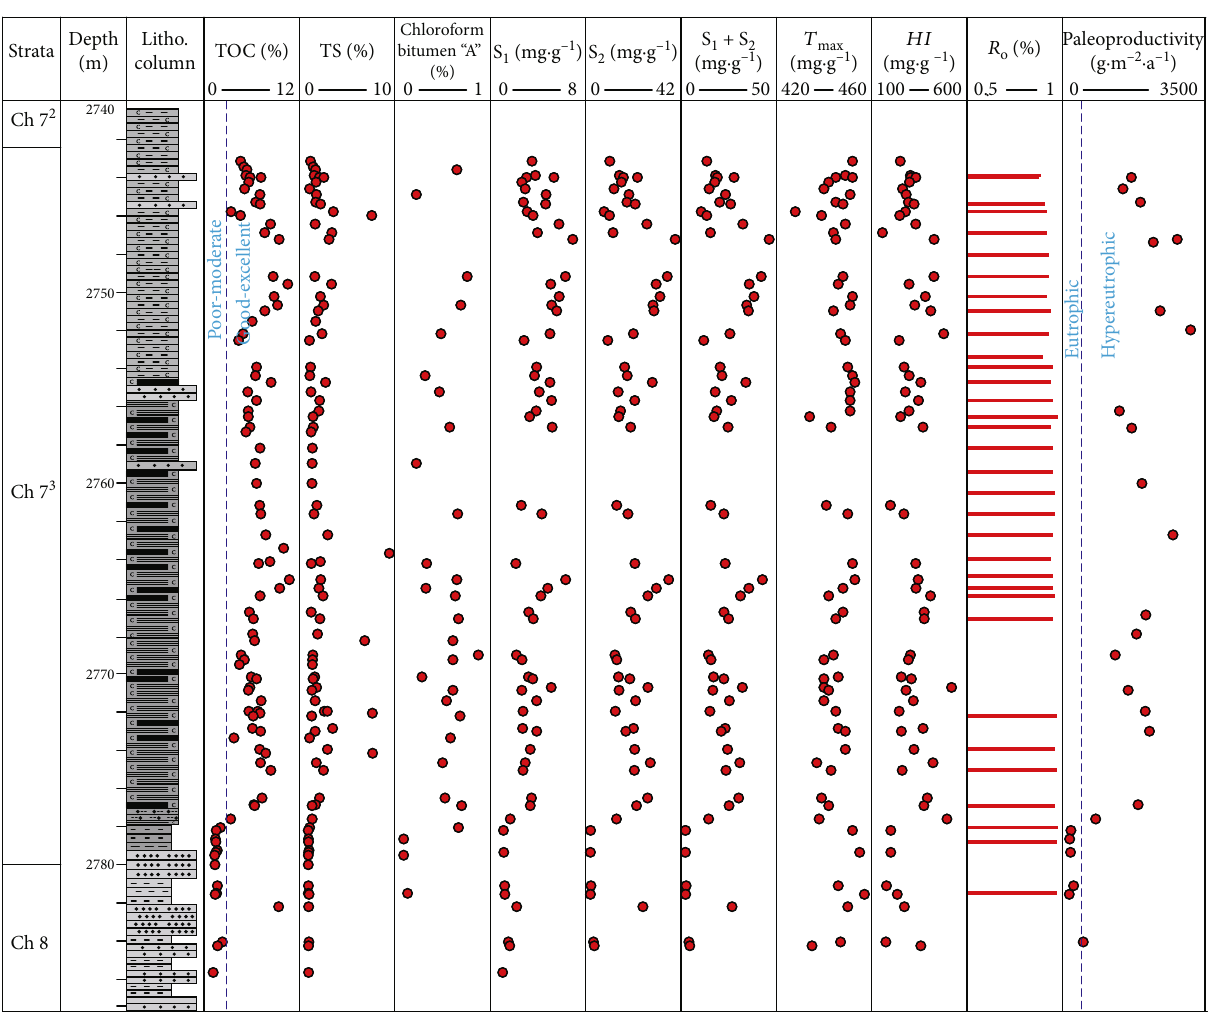
Figure 5: Geochemical log of well DP1 showing total organic carbon (TOC), total sulfur (TS), chloroform bitumen “ A, ” vitrinite re fl ectance, Rock-Eval pyrolysis, and paleo-productivity. Note that the calculation formula of paleo-productivity is shown in Section